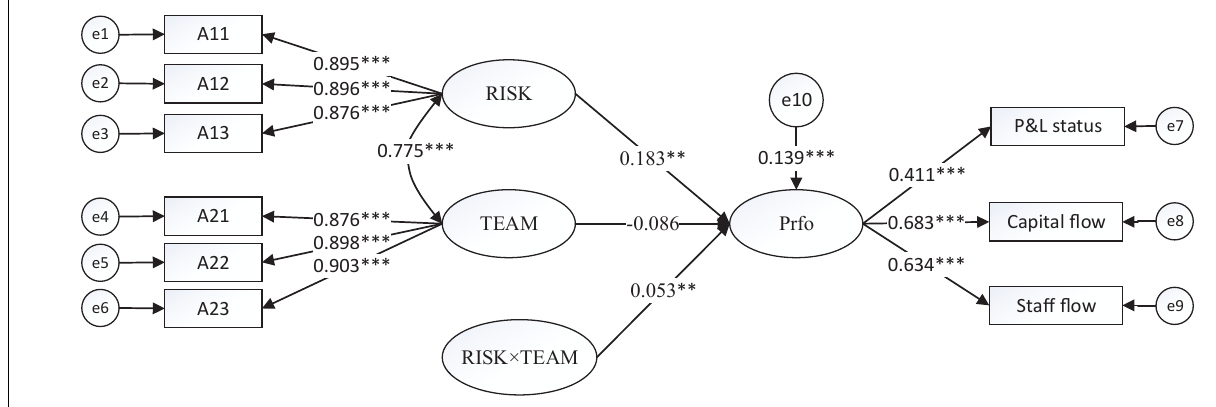
FIGURE 1 | Moderating effect of TEAM on Prfo. ∗∗ p < 0.01, ∗∗∗ p < 0.001.